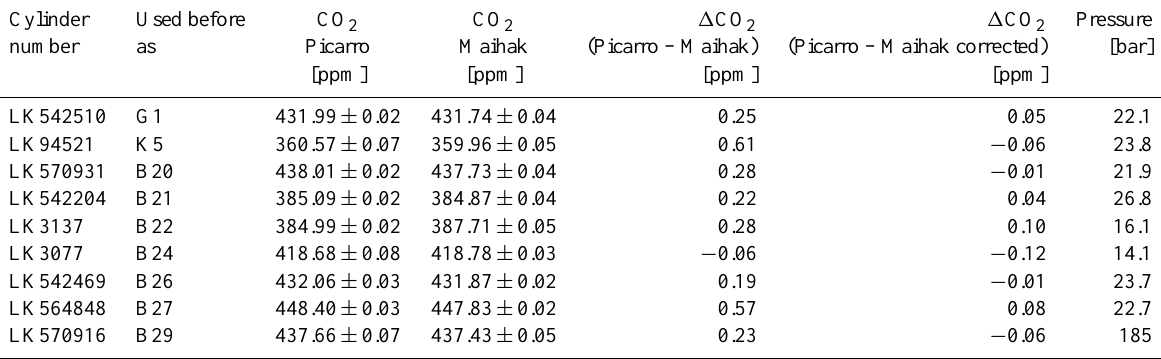
Table 1. KUP calibration cylinders and their measured CO 2 values on the NDIR and the CRDS system. These values were used to calculate the second degree polynomial to correct the nonlinearity of the NDIR system (See also Fig. 9). Cylinder Used before CO 2 CO